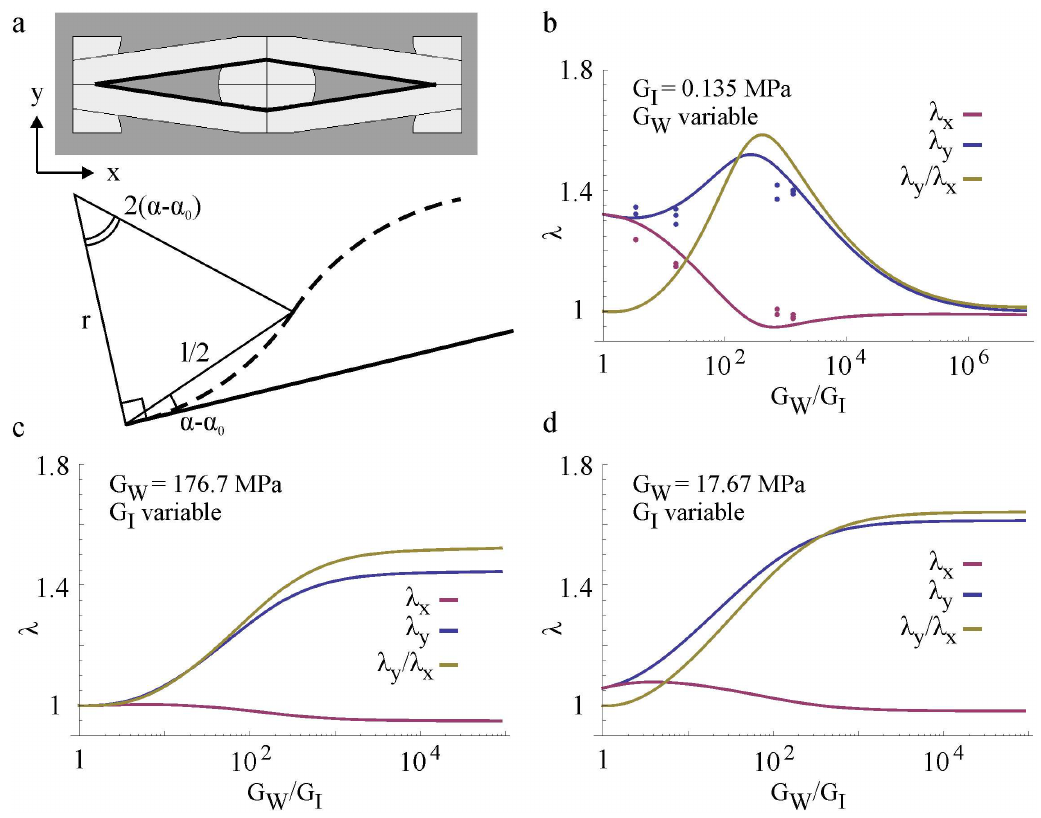
Fig 4. Influence of walls (G W ) and inclusions (G I ) rigidity on the honeycomb swelling deformations (dots: experiments; solid lines: analytical prediction). (a) Schematics to estimate the honeycombwall curvature due to a deformation from straight (solid line) to S-shaped (dashedline). (b) Influence of increasingly rigid walls and constant stiffness inclusions (G MI = 0.135 MPa) on the overall honeycomb expansion.Dots correspondto measuredswellingof 3D printed honeycombs with soft inclusions(G MI = 0.135 MPa) and increasingly stiff walls (respectively, G MW1 = 0.459, G MW2 = 2.089, G MW3 = 96.5 and G MW4 = 176.7 MPa). (c, d) For a fixed wall rigidity (c: G W = G MW4 = 176.7 MPa; d: G W = 0.1 * G MW4 ) and increasingly softer inclusions,the (anisotropic) honeycomb expansionincreasesuntil a plateau is reached. Analytical predictionvalidatedthrough experiments only for case